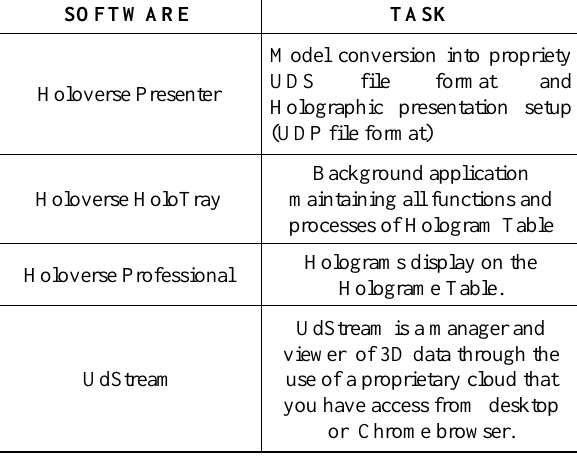
Table 1. Euclideon Holographic software, versions, and tasks.